Question: What kind of plot is shown here?
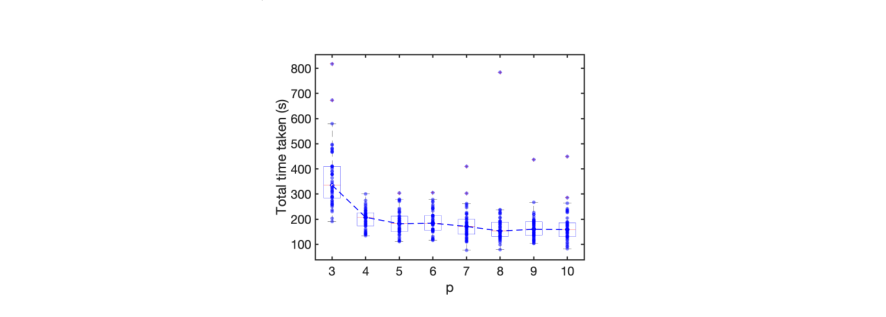
Answer: line